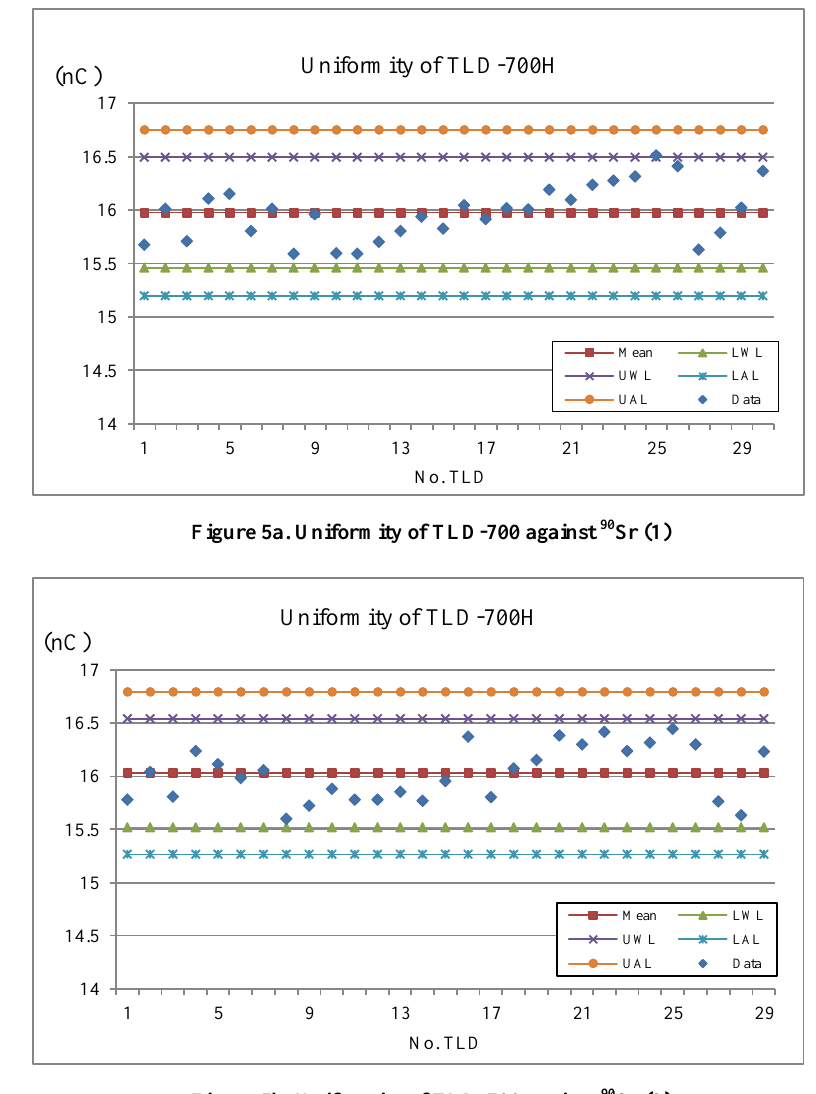
Figure 5b. Uniformity of TLD-700 against 90 Sr (2)